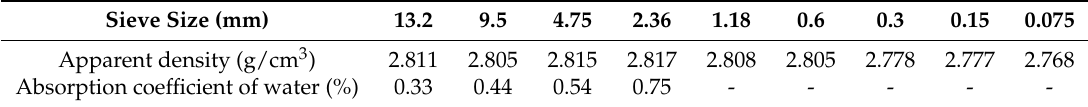
Table 2. Properties of aggregate.